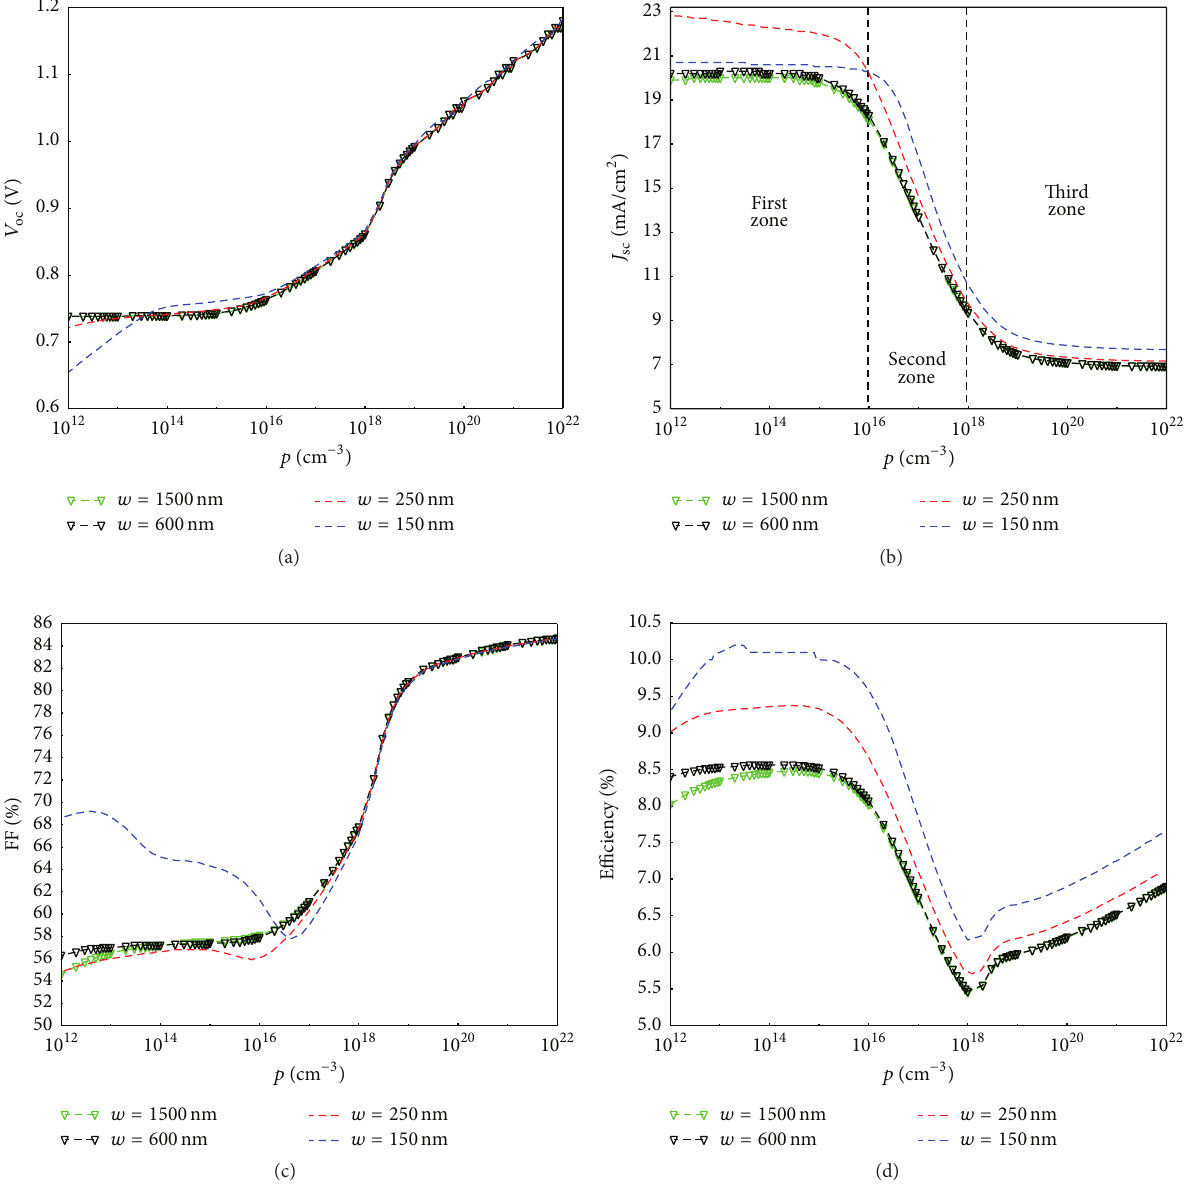
Figure 7: The simulated performance of holes density on 𝑉 oc , 𝐽 sc , FF, and efficiency as a function of the CZTS absorber thickness.